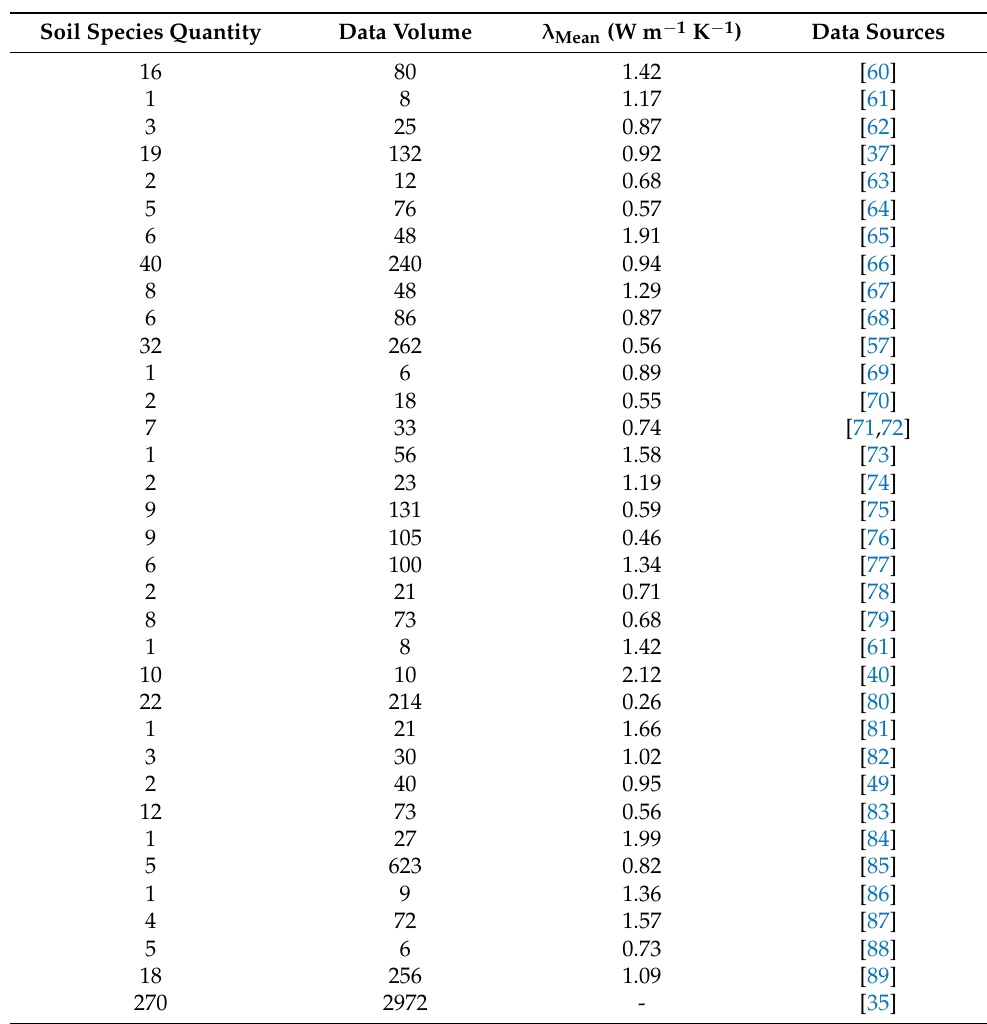
Table 1. The STC dataset used in this study. Soil Species